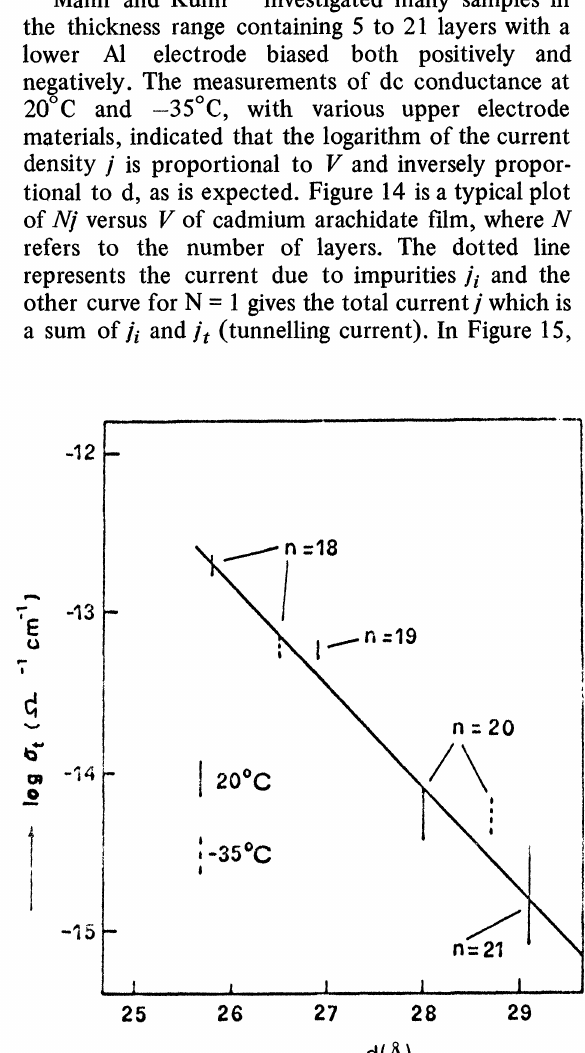
FIGURE 15 Logarithm of a (jtd/V) V 0 (a tunnelling conductivity) vs. d for A1-Cd salt of CH (CH2)n_2COOH-Hg devices at 20C and-35C with n 18 21. [After Mann and Kuhn .] log Ot(O (l- Oi) is plotted against thickness d for four types of cadmium salts of the fatty acids CHa (CH2)n-2 coon with